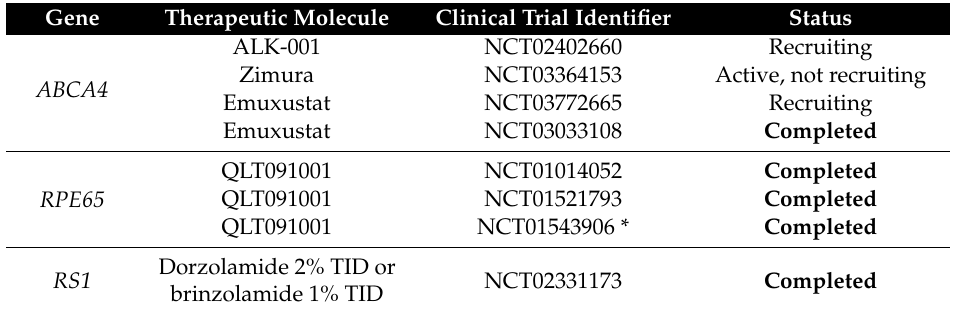
Table 3. Summary of clinical trials for IRDs using compound